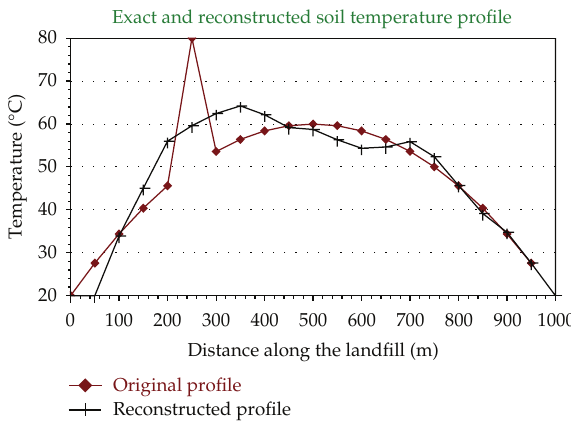
Figure 5: Twenty intervals—Tikhonov’s regularisation factor.